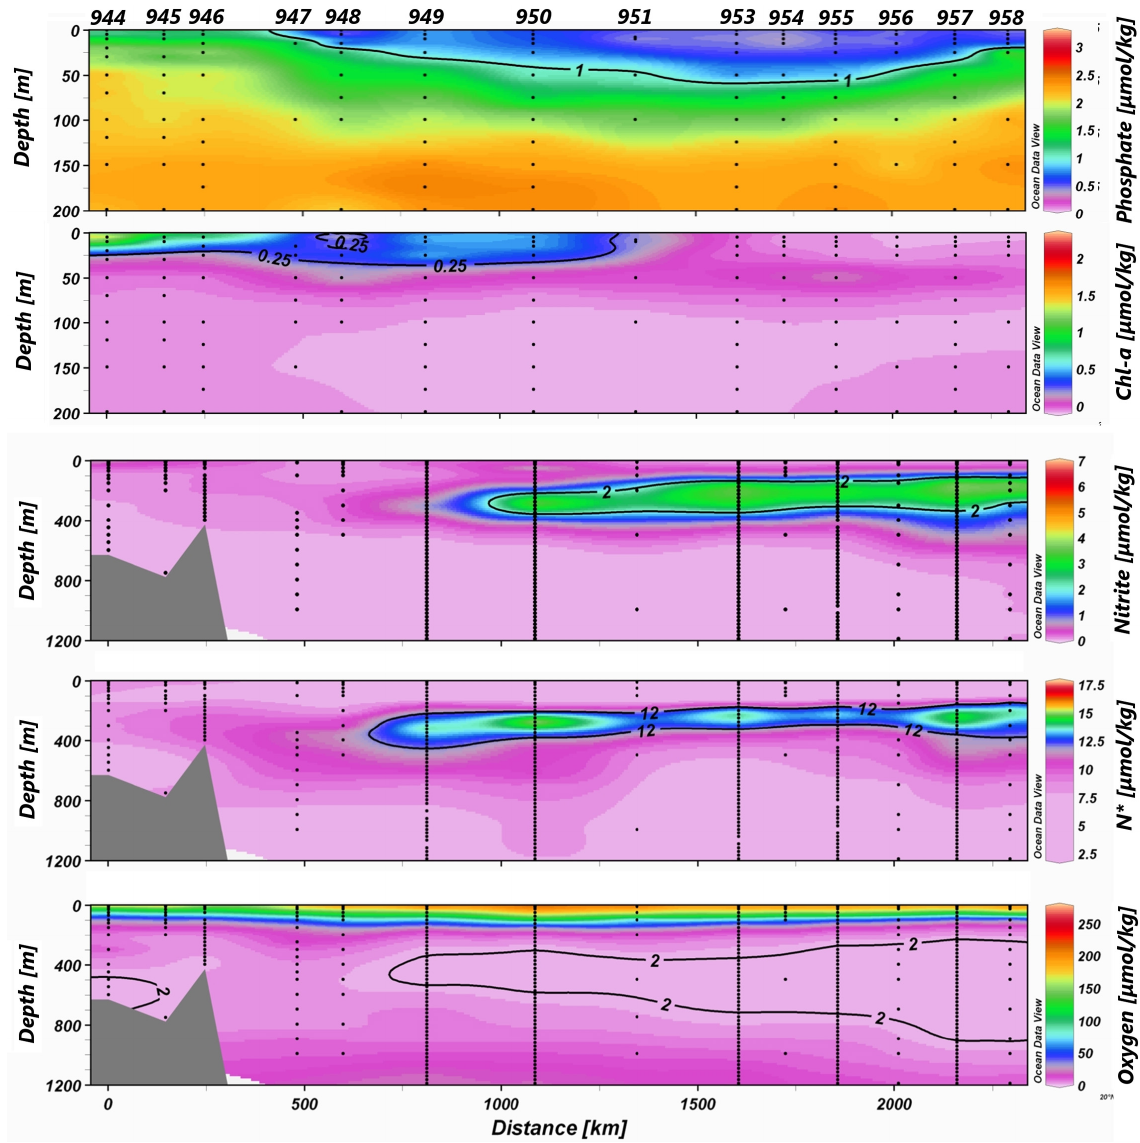
Figure 6. Transects from the western (944) towards the central (950) and eastern Arabian Sea (951–958) obtained during the RV Meteor cruise M74/1b in 2007 (see Table 1). The transect is given in Fig.